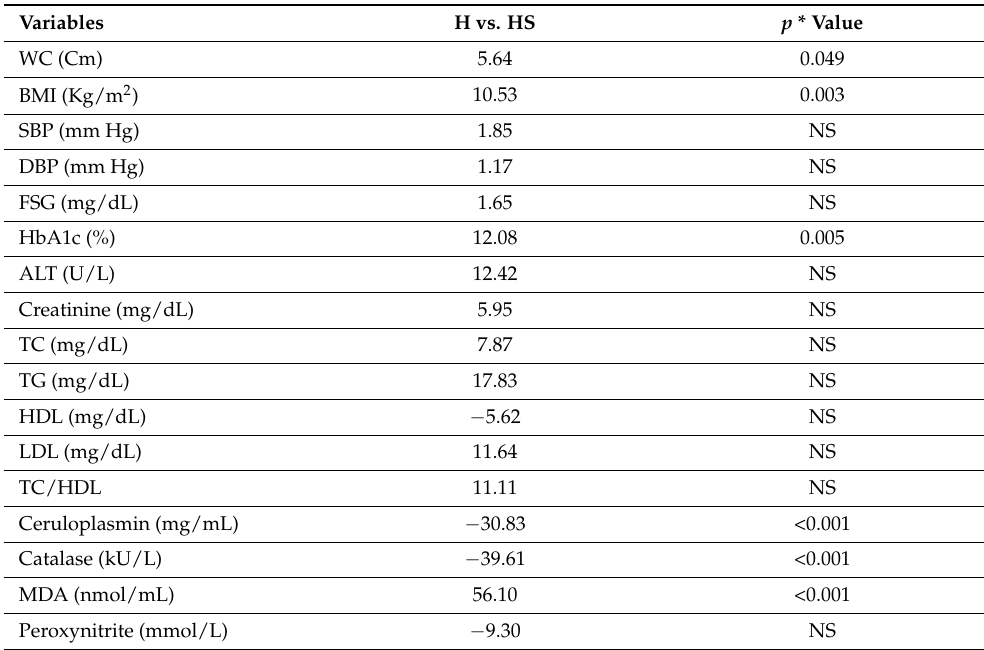
Table 3. Change on anthropometric and biochemical parameters associated with the consumption of artificial sweeteners in healthy